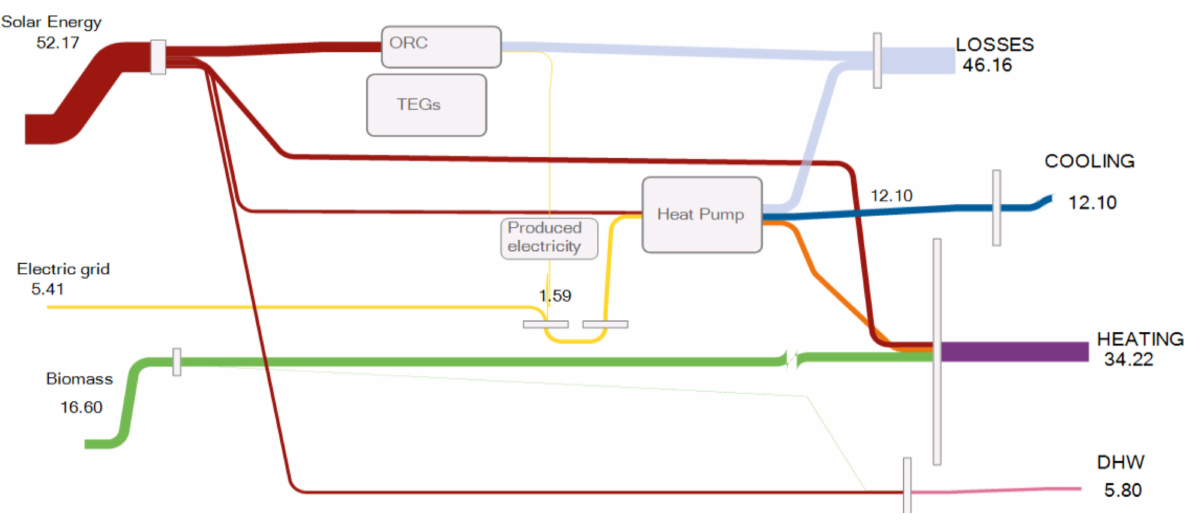
Figure 7. Sankey diagram for Berlin 100% rooftop coverage with solar collectors. All energy flows are in kWh/(m 2